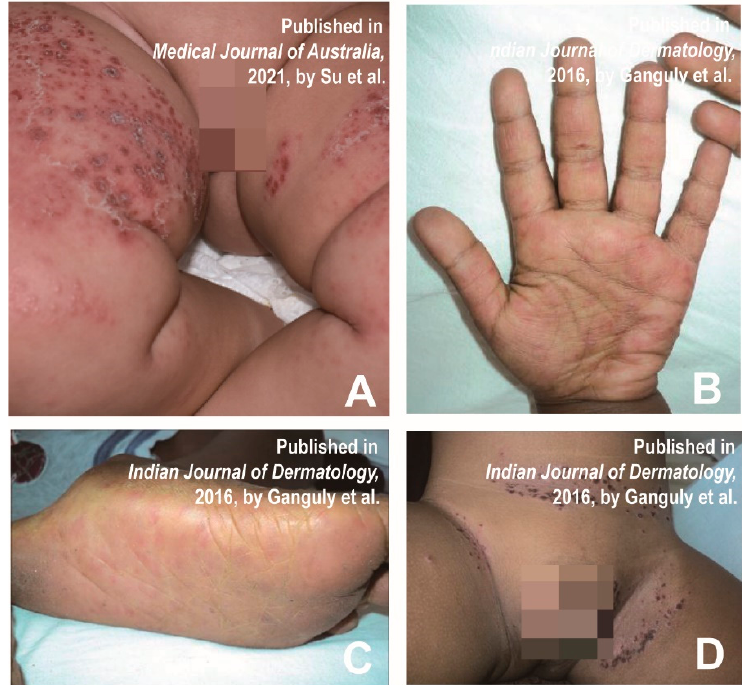
Figure 2. ( A ) Multiple erythematous papules and blisters with crusts on the extremities. Reprinted/adapted with permission from Ref. [23].2021, Su et al. ( B ) Elongated papulovesicles over palm and palmar aspect of fingers. ( C ) Erythematous papulovesicles over soles. ( D ) Crusted papules, vesicles and surrounding erythema and maceration in the groins, abdominal folds, and scrotum. Figures ( B – D ) were reprinted/adapted with permission from Ref. [21]. 2016, Ganguly et al. As eczema coxsackium resembles herpetic eczema, overlapping varicella caused by HSV, the differential diagnosis generally includes varicella-zoster virus infection, herpetic eczema and herpetic impetigo [24]. If necessary, causative agents in the blister fluid could be detected by nucleic acid testing [23]. Table 2 shows the main differential diagnoses of eczema coxsackium and some similar